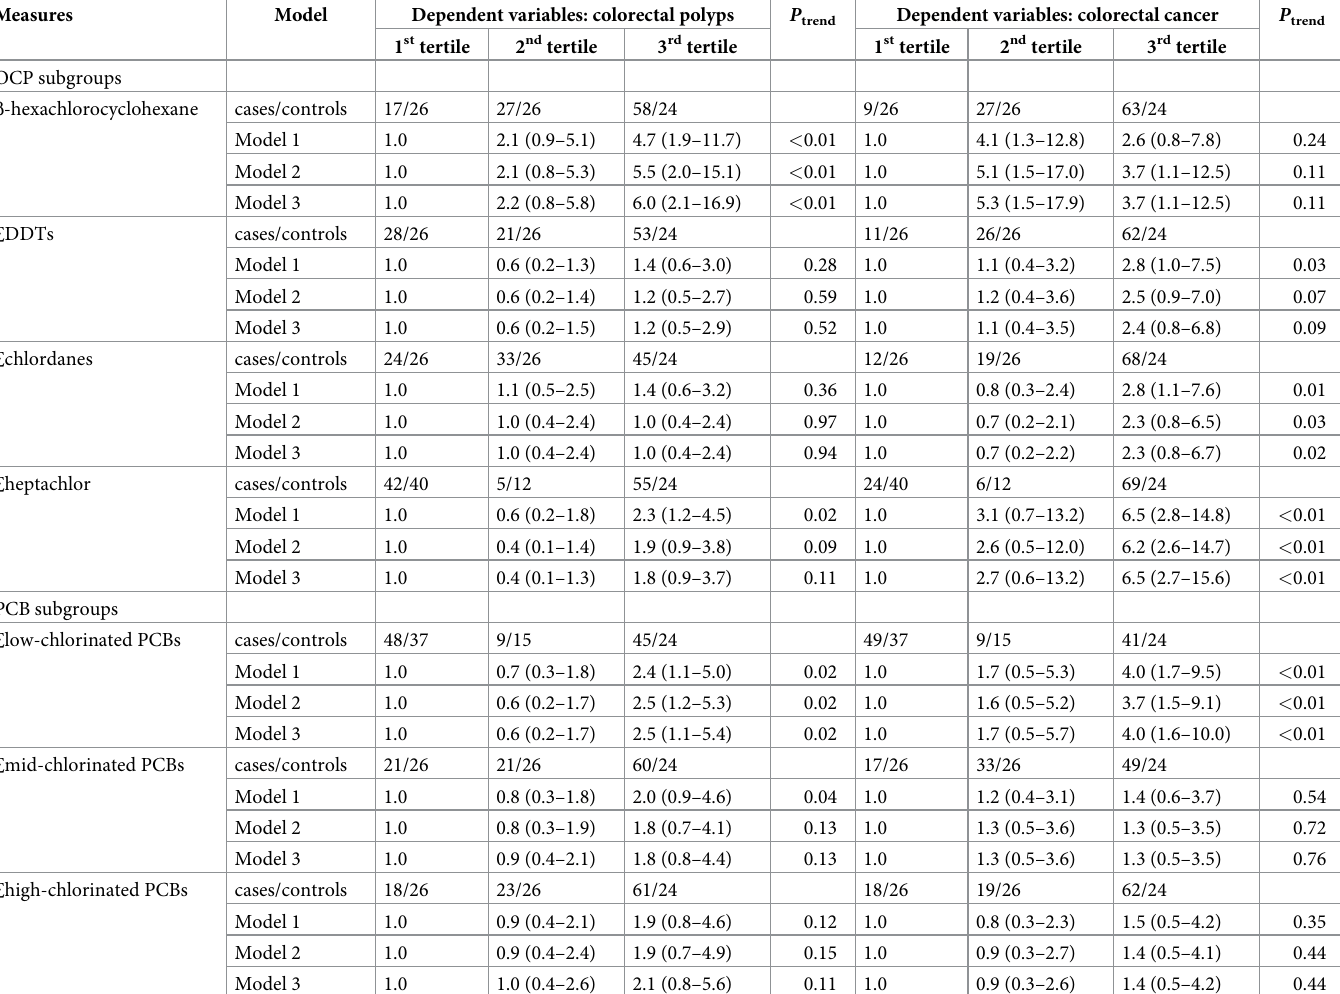
Table 4. Associations between the summary measures of subgroups of organochlorine pesticides and polychlorinated biphenyls and the risk of colorectal polyps or cancer, calculated using polychotomous logistic regression (Odds ratios and 95% confidence intervals). Measures